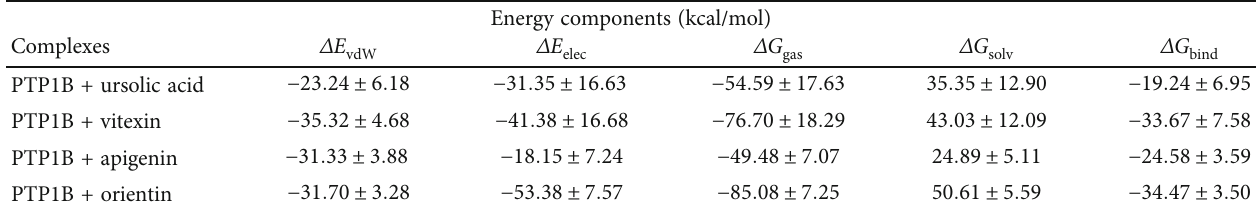
Table 2: Thermodynamic binding free energy component for fl avonoid C-glycosides towards PTP1B.